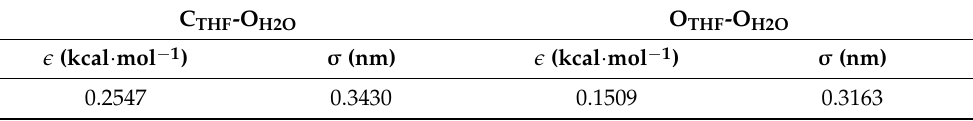
Table 1. Interaction Lennard-Jones Parameters between THF and Water